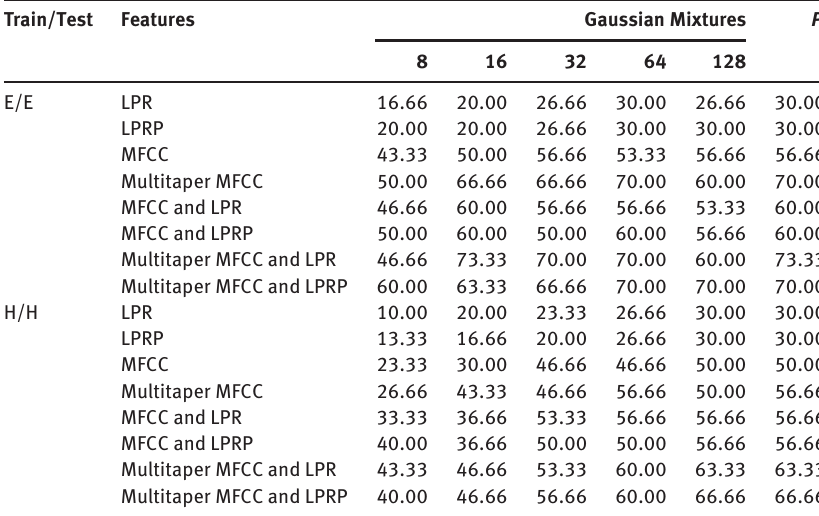
Table 1. The Monolingual Speaker Identification Performance using LPR, LPRP, MFCC, and Multitaper MFCC-Based Individual and Combined System. P Identification Performance among the Number of Gaussian Mixtures.